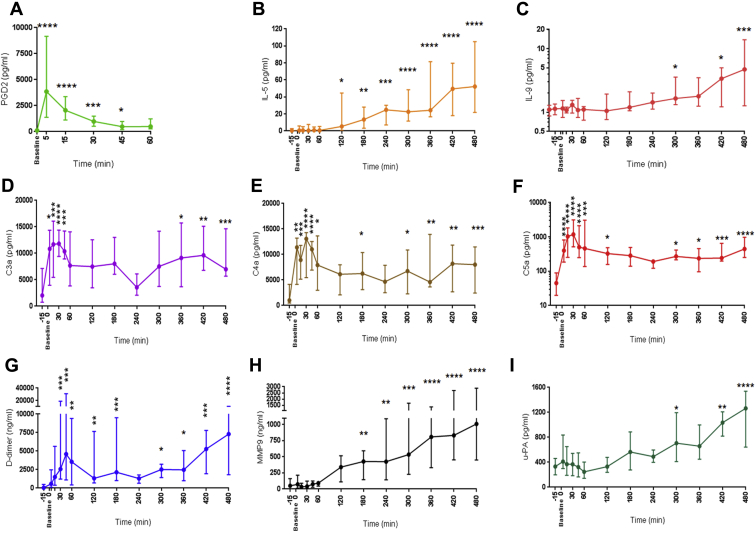
Mediator levels following NAC. Data from Fig 1 are shown as medians and interquartile ranges. Following NAC, mediators and markers of mast cell degranulation, type II inflammation, complement activation, fibrinolysis, and plasminogen activation were measured: A, PGD2 in the first hour post-NAC. B, IL-5. C, IL-9. The complement components (D) C3a, (E) C4a, and (F) C5a. In addition, levels of (G) D-dimer, (H) MMP9, and (I) urokinase (u-PA) were determined (n = 15). Friedman test with Dunn correction for multiple comparisons, based on the level at each time point relative to those at baseline, was used to determine statistical significance (*P < .05, **P < .01, ***P < .001, ****P < .0001). MMP9, Matrix metalloprotease 9.